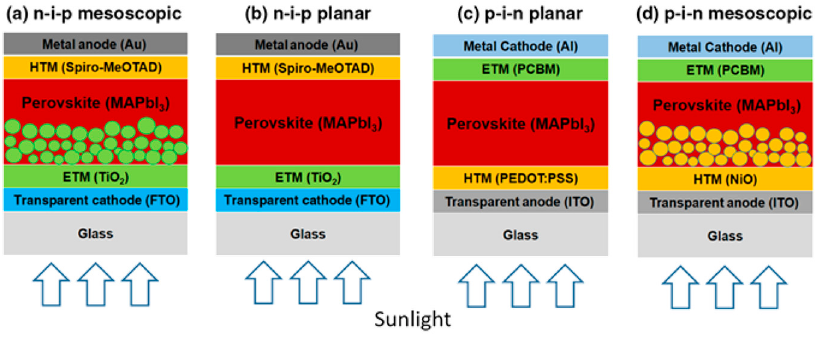
Figure 6. Schematic of perovskite solar cells with ( a ) n–i–p mesoscopic, ( b ) n–i–p planar, ( c ) p–i–n